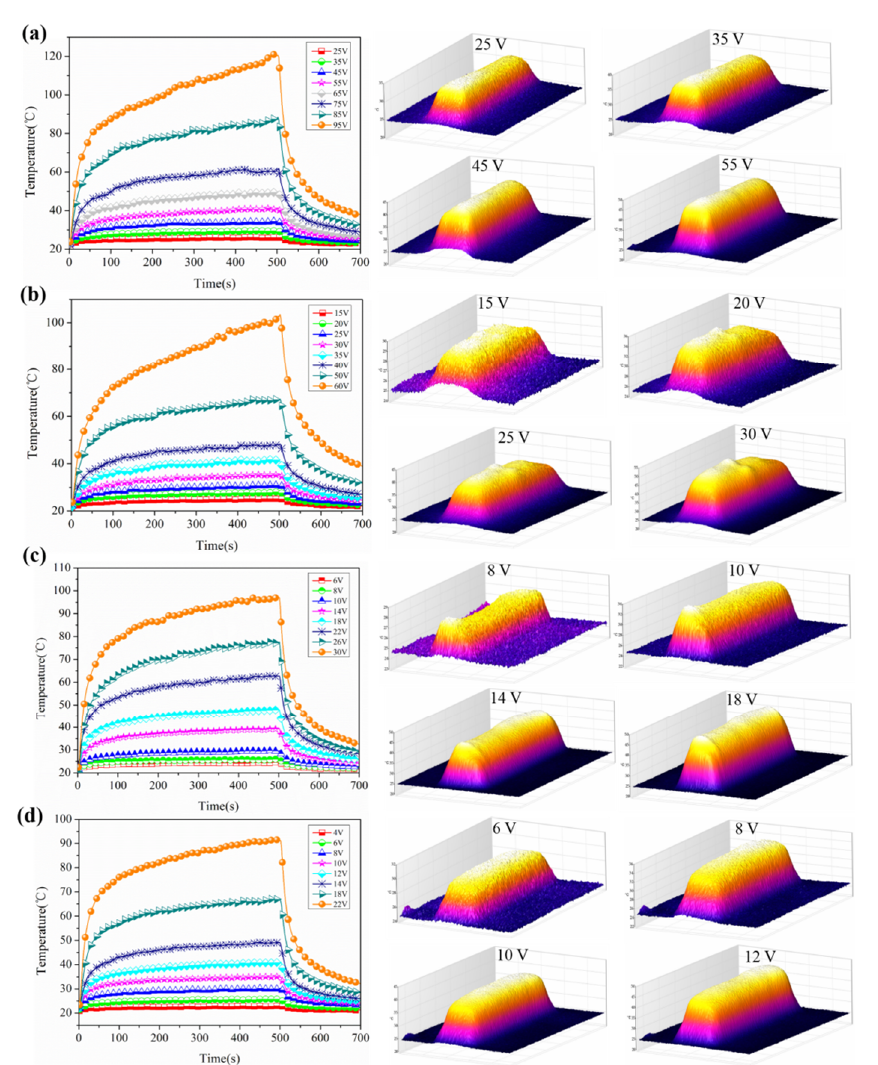
Figure 5. Time–temperature curves and infrared images of GO/CCNF films. ( a ) GO/CCNF–30%; ( b ) GO/CCNF–40%; ( c ) GO/CCNF–50%; ( d )